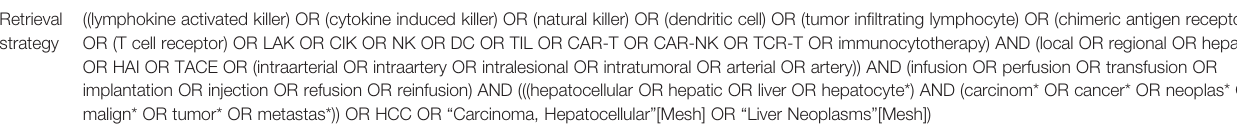
TABLE 1 | Retrieval strategy on